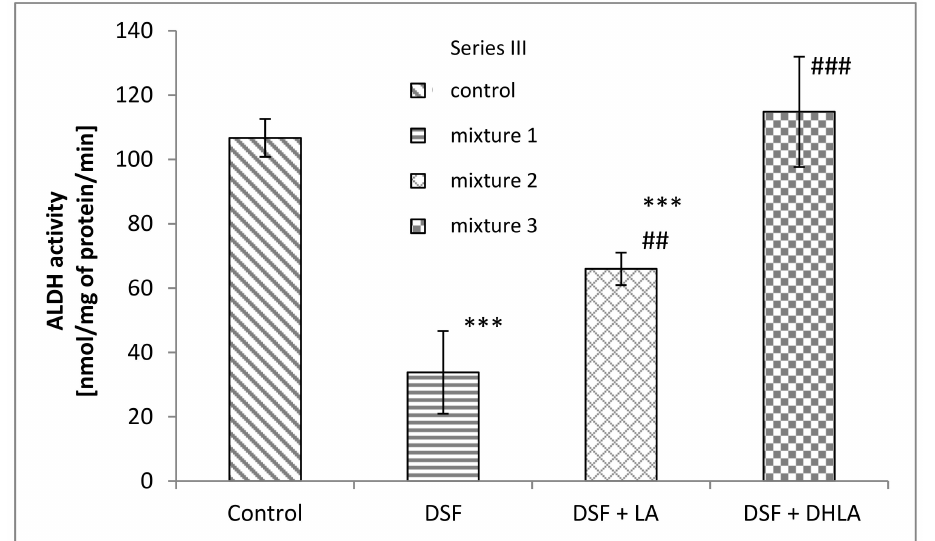
Figure 6. The e ff ect of DSF preincubated with LA / DHLA on the activity of rat liver-derived ALDH. DHLA and to a lesser extent LA, were able to protect ALDH activity against the inhibitory e ff ect of DSF. The experiment was performed in triplicate. Data are shown as the mean ± SD. Significant vs.